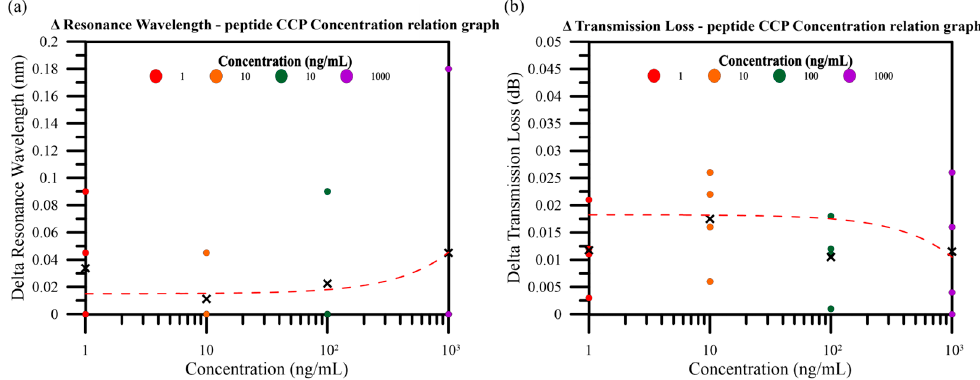
Figure 9. Relationship between CCP antigen concentration and the variation in the ( a ) resonant wavelength shift and ( b ) transmission loss. Table 1. CCP biomedical immunoassay literature compilation.